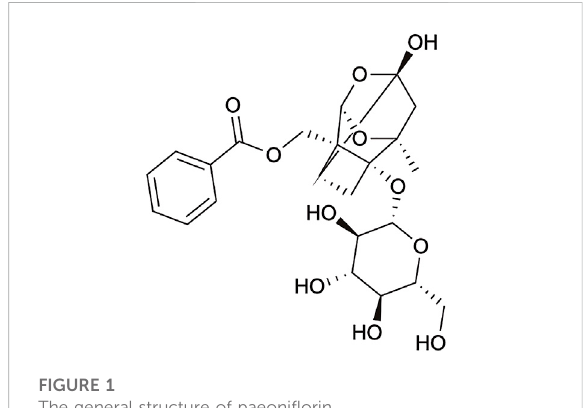
The general structure of paeoni fl